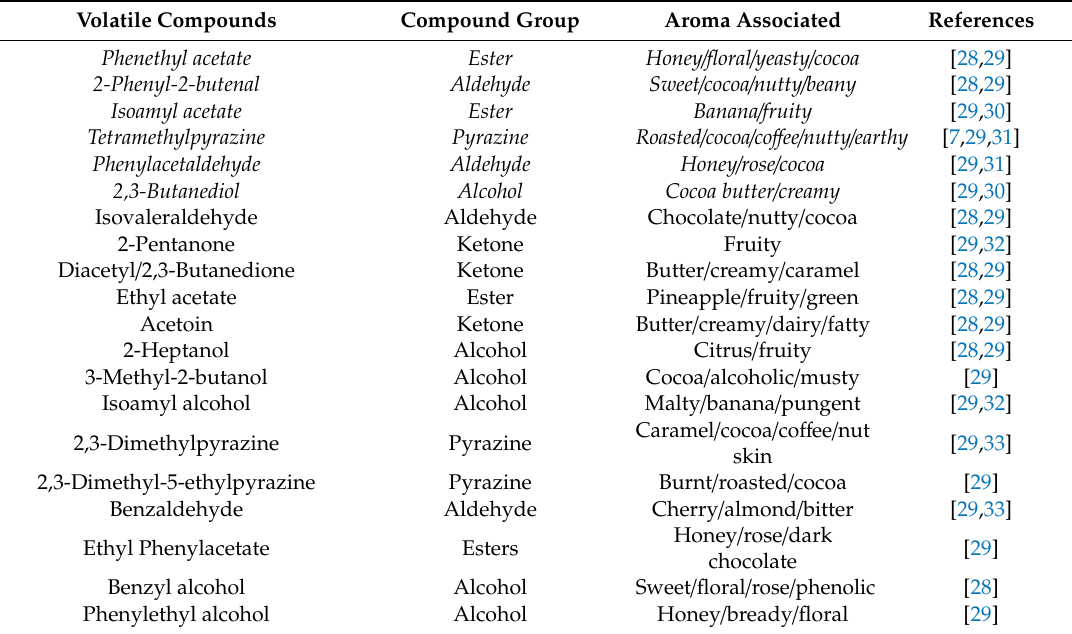
Table 3. Major volatile compounds found in the fermented cocoa beans, and the associated